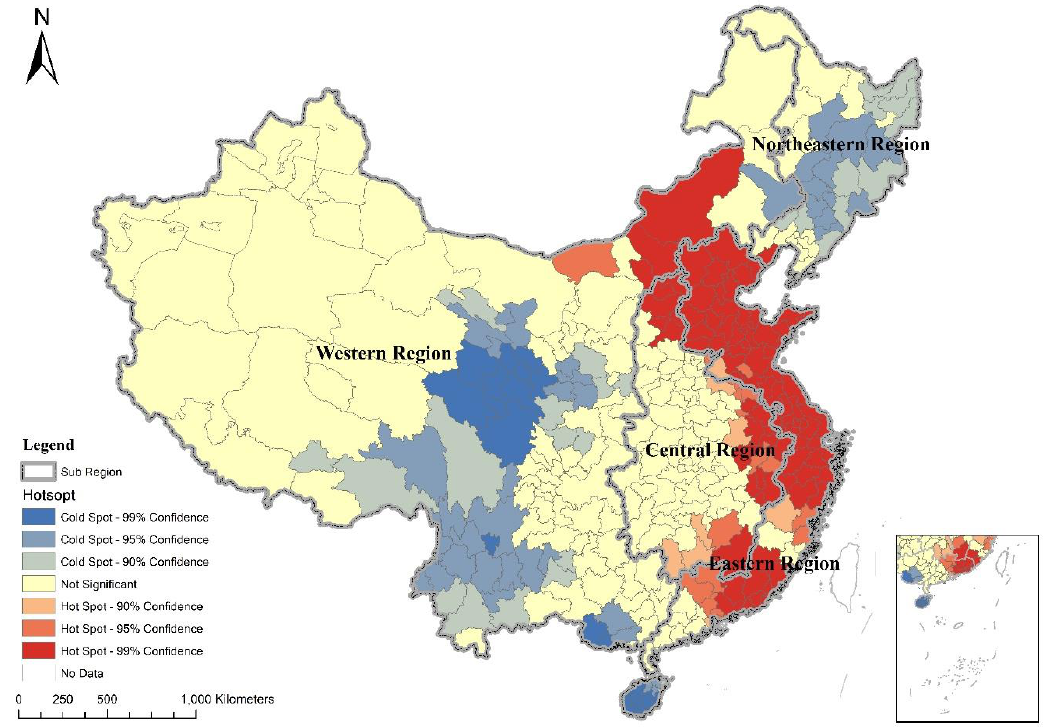
Figure 4. Hot and cold spots of urban expansion in China during 1990 – 2015.